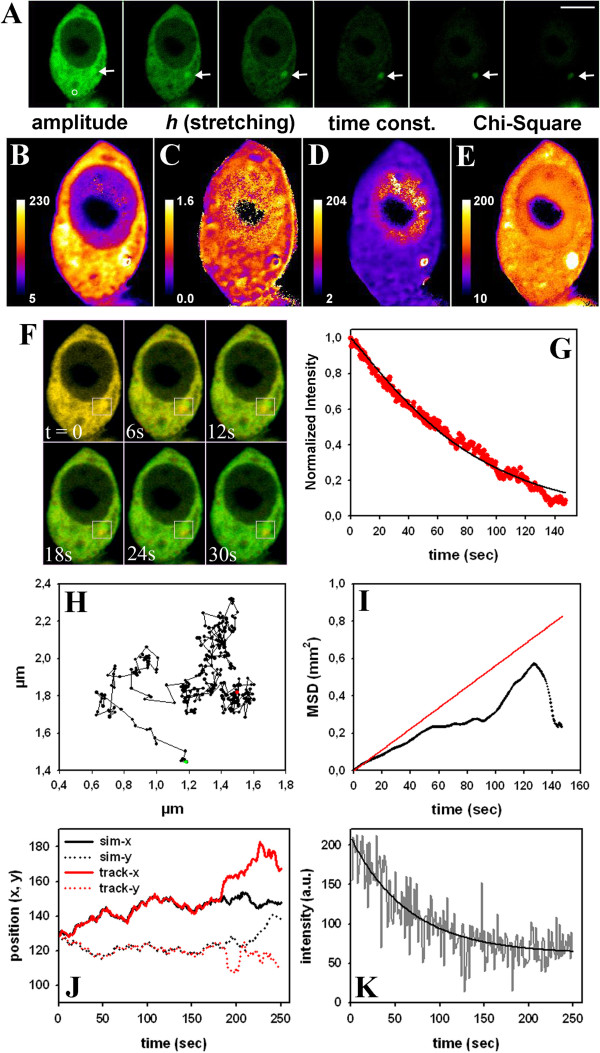
Quantitative FLIP and single particle tracking of mobile IB’s in the cytoplasm. A FLIP experiment with a bleach region of 10 pixels in diameter was performed in CHO cells expressing eGFP-Q73 on a temperature-controlled stage of a confocal microscope maintained at 35 ± 1°C. The total frame rate was 1.45 sec. A, montage of every 20th frame of the data. Arrows point to an inclusion body (IB) in the cytoplasm. B-E, pixel-wise fit of the data to a StrExp function with B, amplitude map; C, map of the stretching parameter; D, time constant map; E, χ2-values showing the quality of the regression. All values are color-coded using a FIRE-LUT, and the range is indicated by the respective color bar. The time constant is given in seconds; all other values are without units. F, first frame of the time series is shown in green, while selected subsequent frames are overlayed in red (box in F shows movement of the IB). G, FL of eGFP-Q73 in the IB (red symbols) with fit to the StrExp function (black line). H, x,y-plot of the trajectory of the IB during the FLIP experiment. I, mean square displacement (MSD) calculated from the trajectory and linear fit to the five intital data points (red line). J, K, simulation and tracking of a particle experiencing FL with a rate constant, k = 0.01 sec-1. J, trajectory separated in x- (straight lines) and y-direction (dotted lines) for a particle undergoing bleaching (black lines, simulated trajectory; red lines, tracked trajectory). The tracked trajectory coincided with the simulated trajectory until to 180 sec (or frames). K, intensity of the tracked particle (grey lines) compared to a mono-exponential fit with residual. Bar, 5 μm.